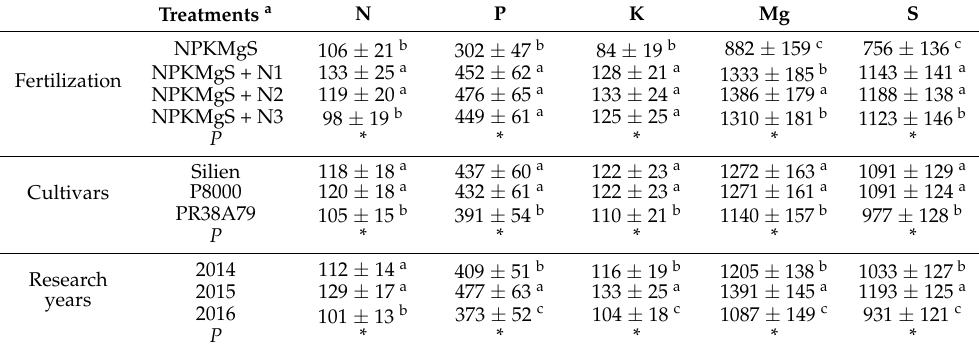
Table 7. Agronomic efficiency of nitrogen, phosphorus, potassium, magnesium and sulphur treatment (kg · kg − 1